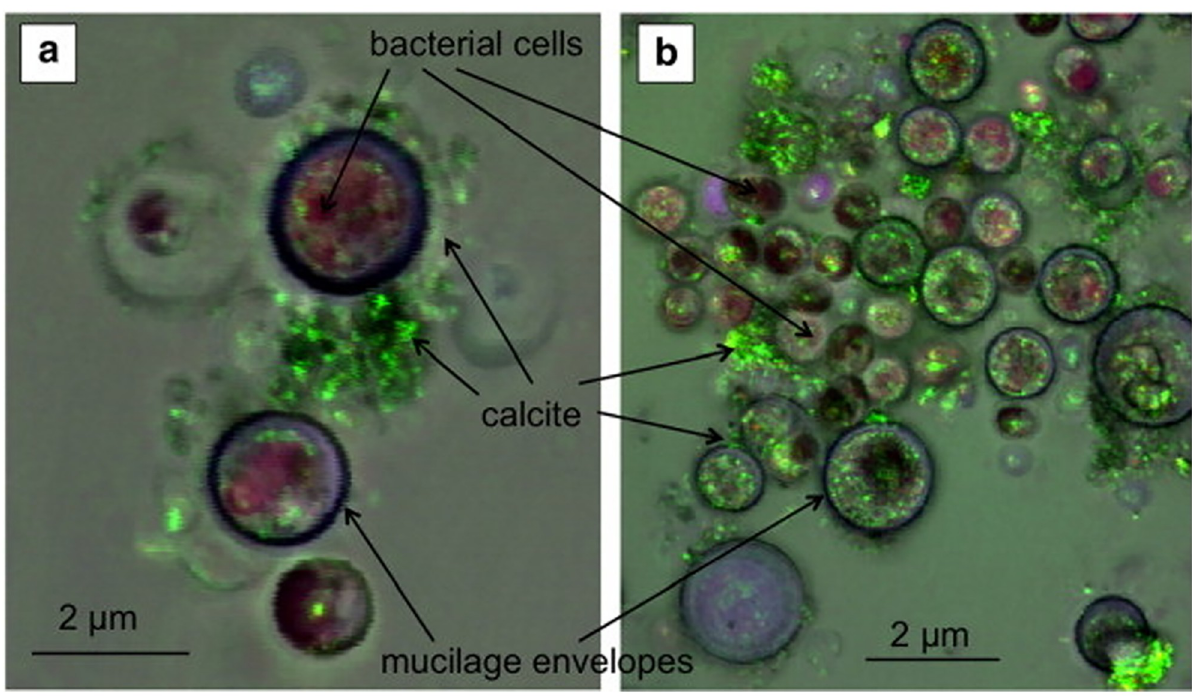
Fig 2. Photosynthesis during cyanobacteria